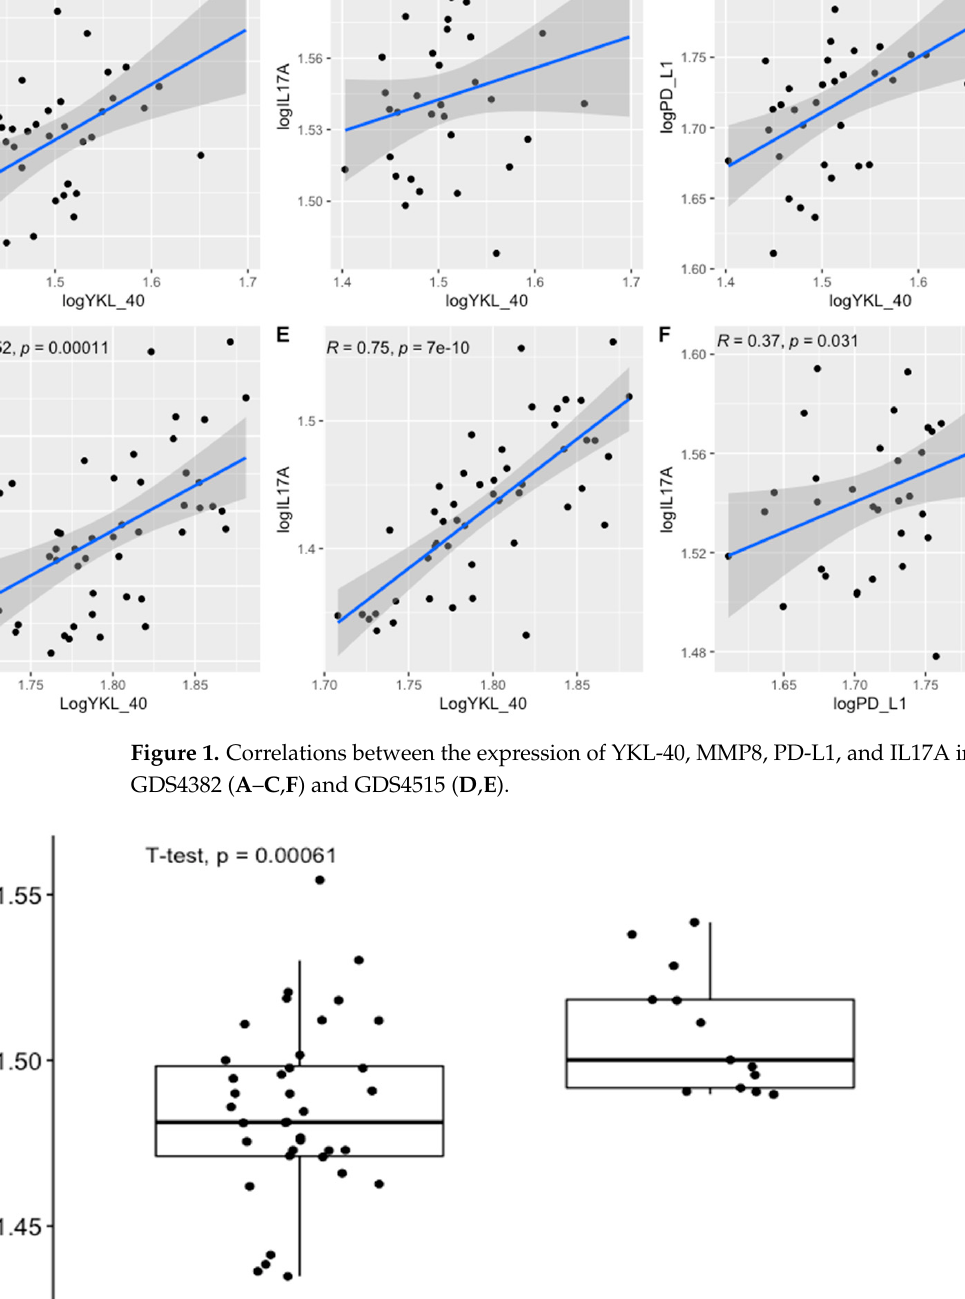
Figure 2. Differences in YKL-40 expression levels between relapse and non-relapse groups of CRC patients in GEO dataset GDS4513.